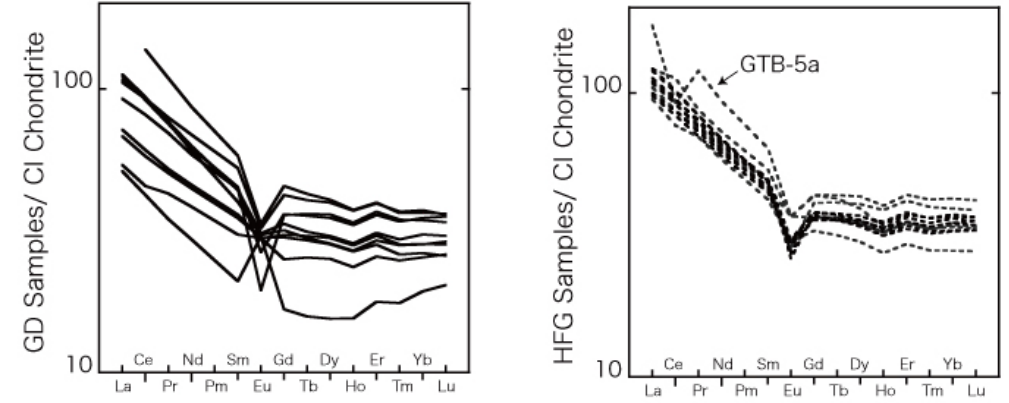
Figure 10. Chondrite-normalized REE diagrams for the Hisakajima Island rocks—( left ) GD group samples; and ( right ) HFG group samples. Normalization values from [25].